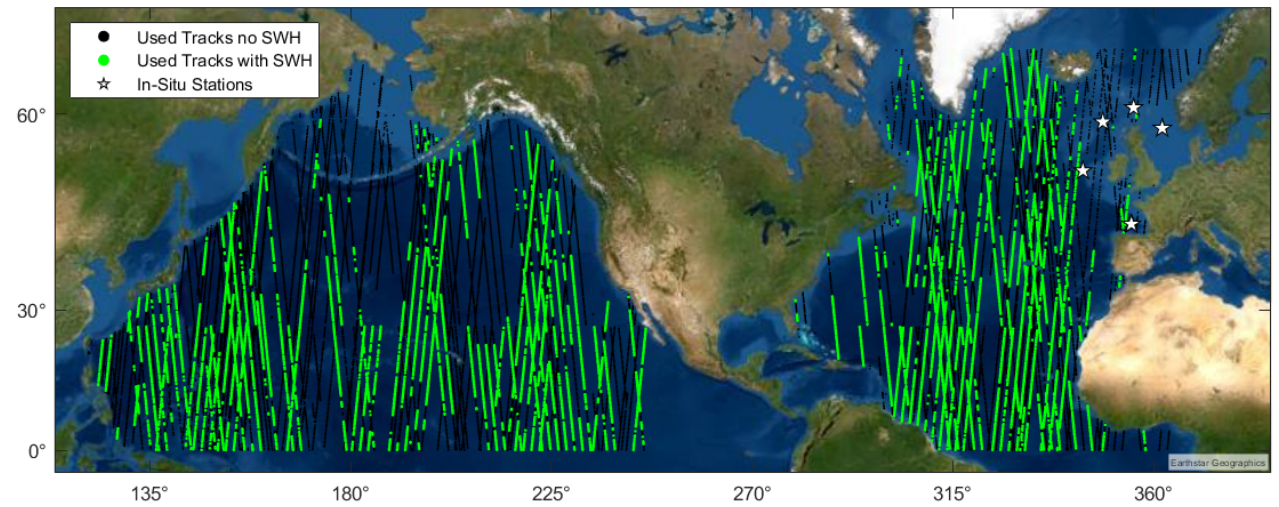
Figure 1. CryoSat-2 orbits (black) in the Pacific and Atlantic oceans, as well as the Bering Sea, for the period from 1 August 2020 to 1 August 2021, that are coincident with ICESat-2 and contain wave height measurements (green). 136 CryoSat-2 orbits from this period have been found to be both coincident with ICESat-2 and more than 40 km from land. The analysis has been limited to latitudes between 0 and 70 degrees north. White stars indicate the locations of the in situ stations used to validate the CryoSat-2